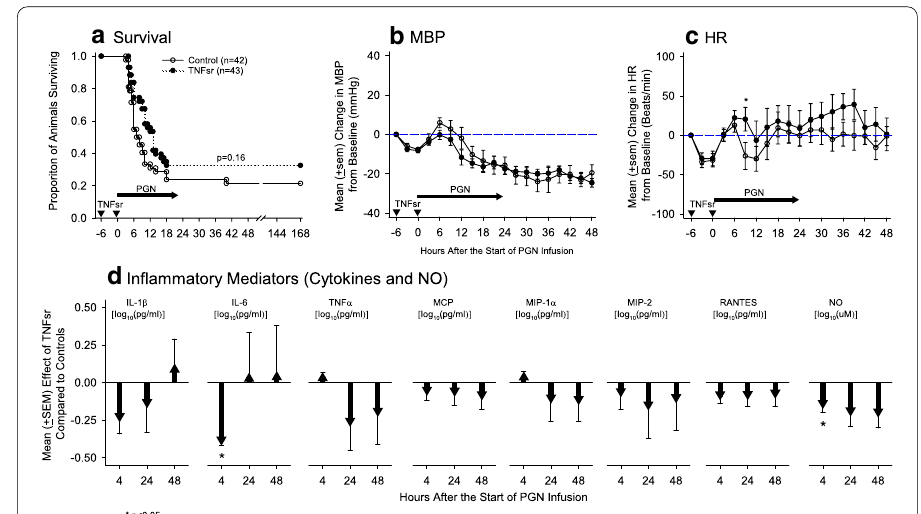
( SEM) effect of TNFsr compared to control] lactate [log 10 (mmol/l)] at both 4 and 48 h ± ( 0.18 0.06 and 0.21 0.09) and increased serum sodium at 24 h (1.6 − ± − ± ( p 0.05. Table 2 and Additional file 1: Table S6). Compared to controls, TNFsr did not ≤ alter any other parameter measured at any time point significantly ( p > 0.05 for